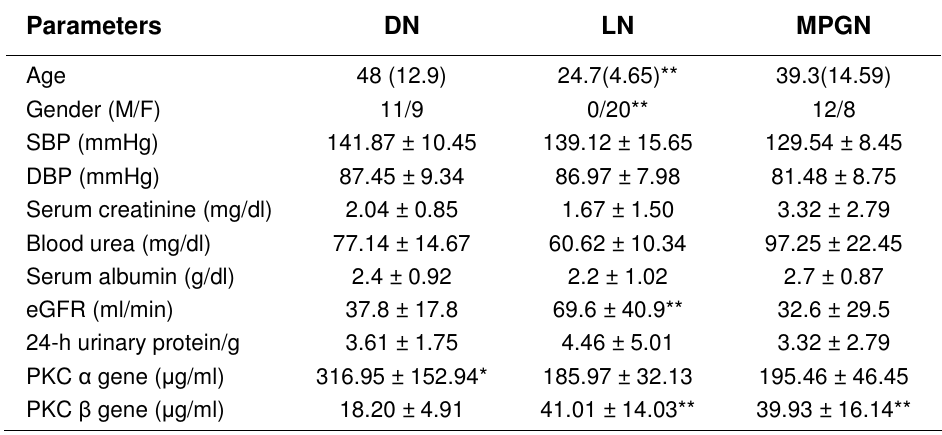
The Main Demographic Characteristics, Laboratory Parameters, and PKC Isoform Expression Levels among the Study